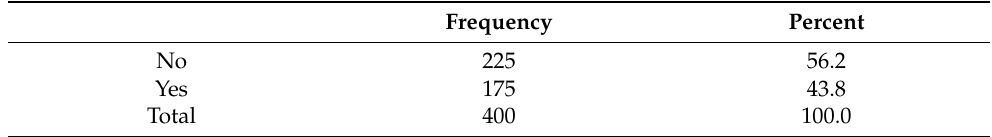
Table 1. Level of Familiarity with forums, structures and mechanisms.